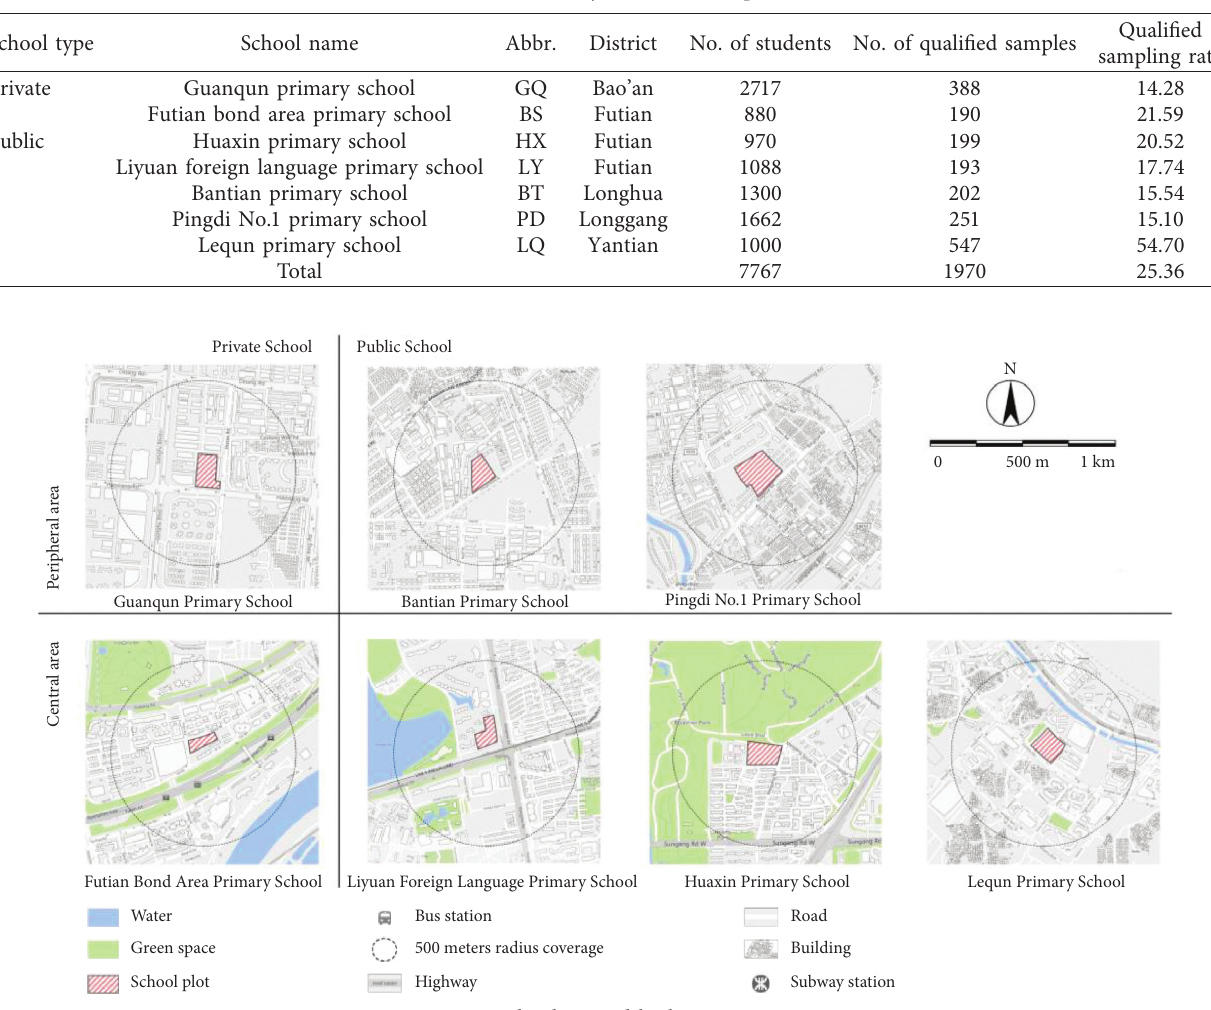
Table 1: Summary for school